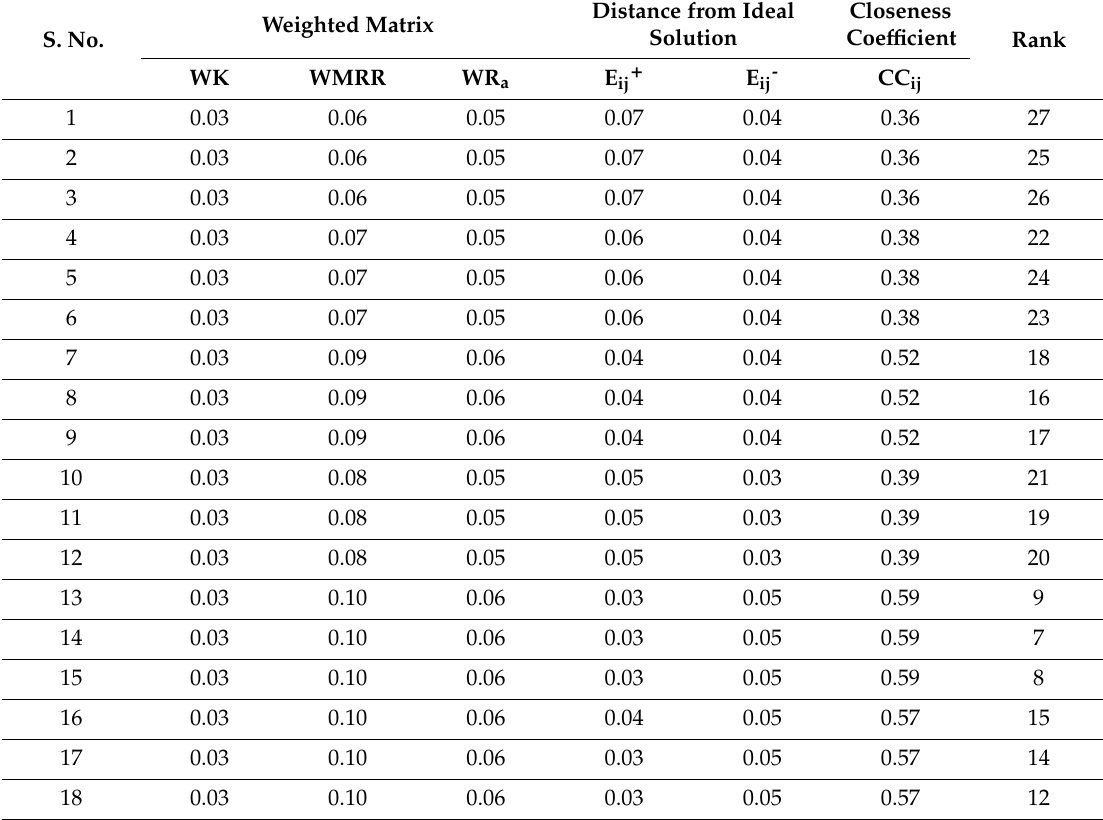
Table 10. TOPSIS evaluation for wire electrical discharge cutting of the Al-SiC-TiC metal matrix composite under an oil + para ffi n + wax dielectric